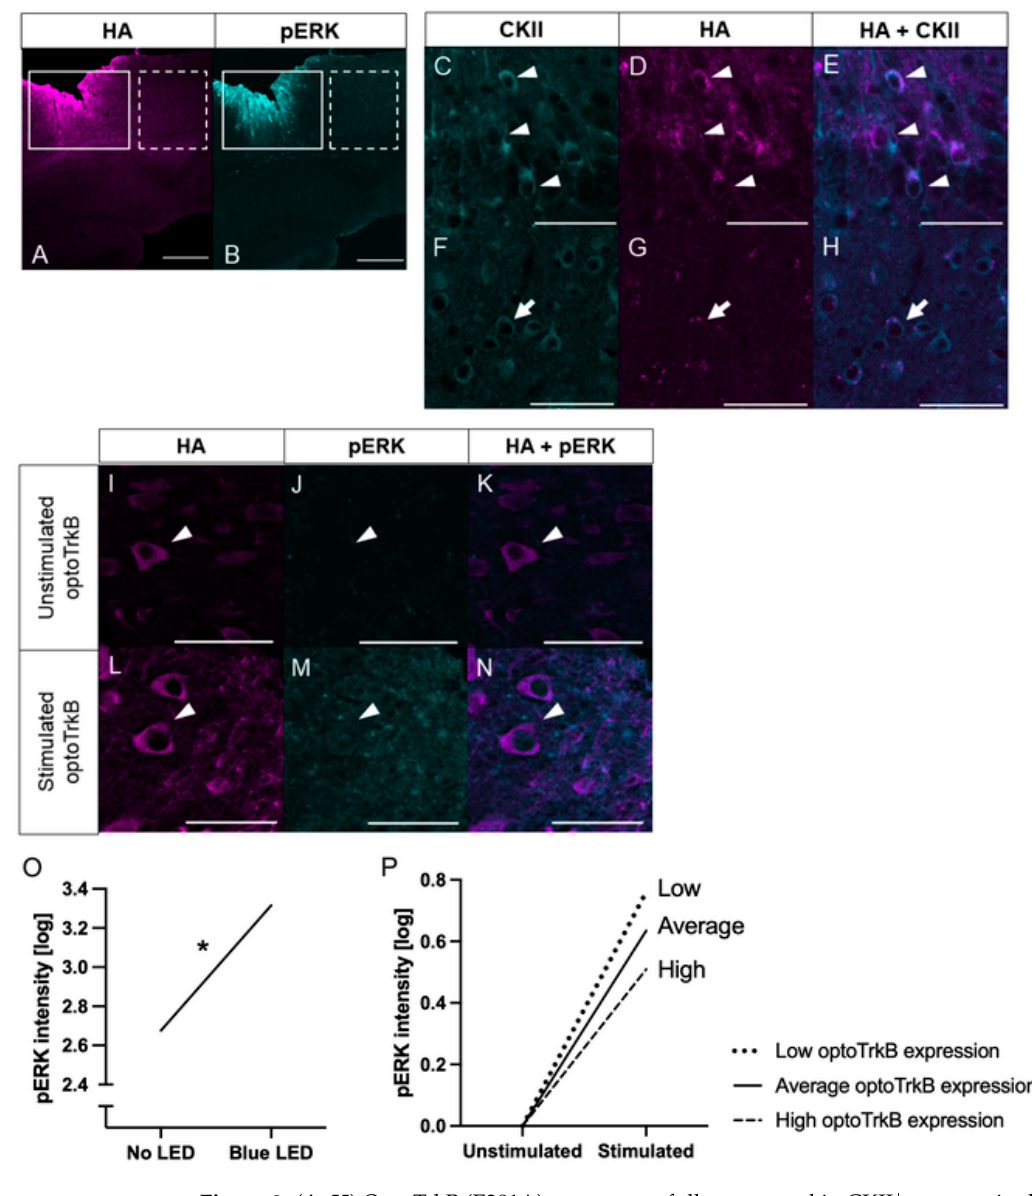
Figure 3. ( A – H ) OptoTrkB (E281A) was successfully expressed in CKII + neurons in the visual cortex of CKII-Cre mice. Representative images of V1 stained with anti-CKII antibody ( C , F ), HA antibody ( A , D , G ), pERK antibody ( B ), and merged CKII and HA ( E , H ). HA expressing neurons also express CKII, indicating that optoTrkB (E281A) was specifically expressed in CKII + neurons. Solid outline, dashed outline, arrowheads, and arrows indicate the infected area, non-infected area, CKII + neurons infected with optoTrkB (E281A), CKII + neurons not infected with optoTrkB (E281A), respectively. ( I – N ) LED Light stimulated CKII + neurons show higher pERK intensity than unstimulated CKII + neurons. Representative images of V1 neurons stained with antibodies of anti-HA ( I , L ), anti-pERK ( J , M ), and merged ( K , N ). Neurons in stimulated ( L – N ) and unstimulated ( I – K ) hemispheres. Ar- rowheads point to CKII + -neurons infected with optoTrkB (E281A). Scale bar ( A , B ) = 500 um; scale bar ( C – N ) = 50 um. ( O ) Regression slope for the effect of LED Light Stimulation on pERK. Op- toTrkB (E281A) stimulation significantly increased pERK intensity for CKII + neurons. The regression equation is as follows: ( pCREB = 2.676 + 0.640 ∗ LEDstimulation + 0.007 ∗ HAintensity + error ). * p < 0.05. ( P ) LED light stimulation increases optoTrkB (E281A) downstream signalling in CKII + neurons to an equal extent in neurons expressing low ( β 1 = 0.761, dotted line), average ( β 1 = 0.635, solid line) and high ( β 1 = 0.509, dashed line) optoTrkB (E281A)